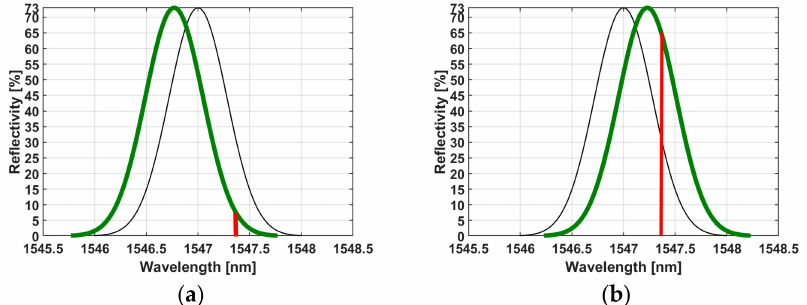
Figure 3. ( a ) Fiber in the compressive state (green) and resting state (black) with a tunable laser at a fixed wavelength of 1547.3 nm and 10% of the light reflected. ( b ) Fiber in the tension state (green) with a tunable laser at a fixed wavelength of 1547.3 nm and 65% of the light